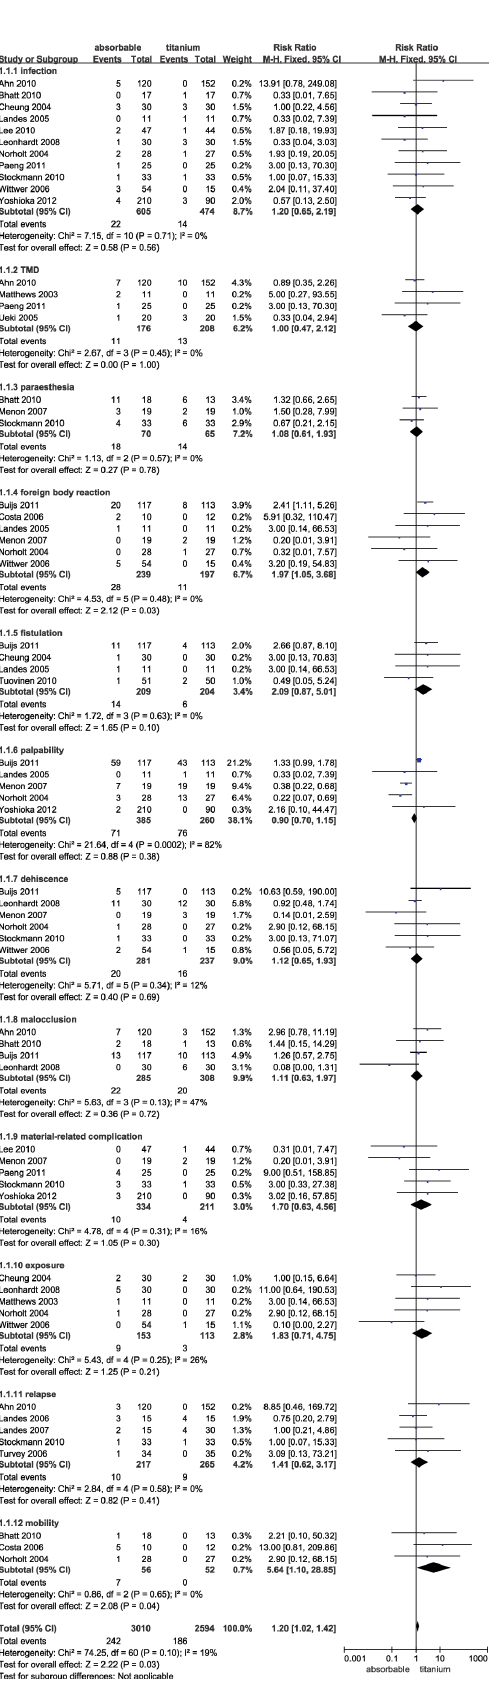
Figure 1. After title and abstract evaluation, 123 articles were identified for further assessment. After a full-text review, 27 met the criteria for inclusion. Complications were reported in 20 of the